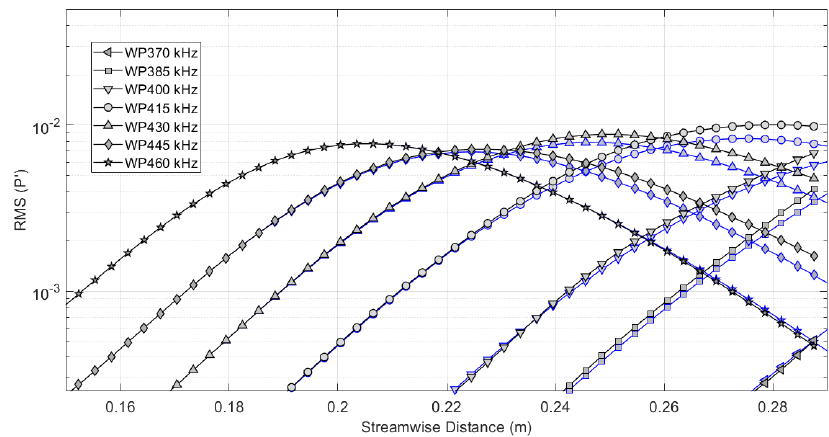
Figure 5. NPSE results for the 4 m flared cone at Notre Dame Tunnel